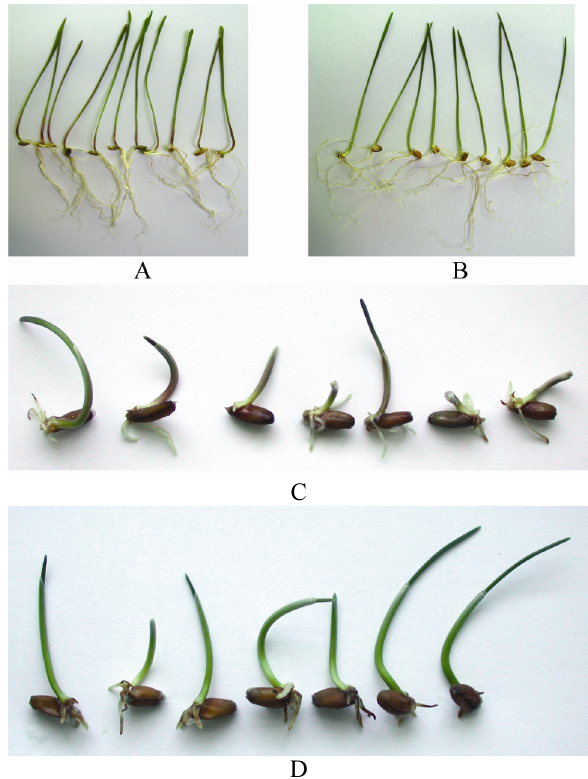
Fig. 1. The influence of MEA waste on shoots growth: A – rye (control); B – wheat (control); C – rye (MEA dilution with water 1:120); D – wheat (MEA dilution with water 1:120)